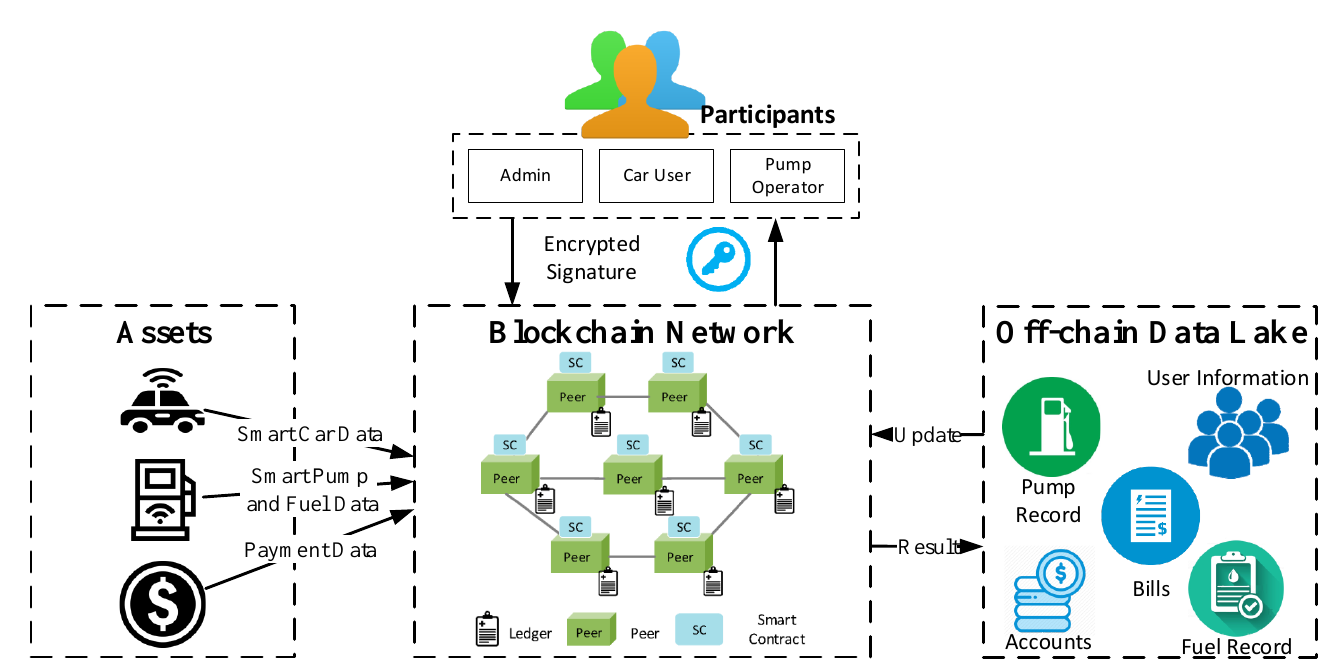
Figure 2. Conceptual model of the privacy-preserving payment service with smart